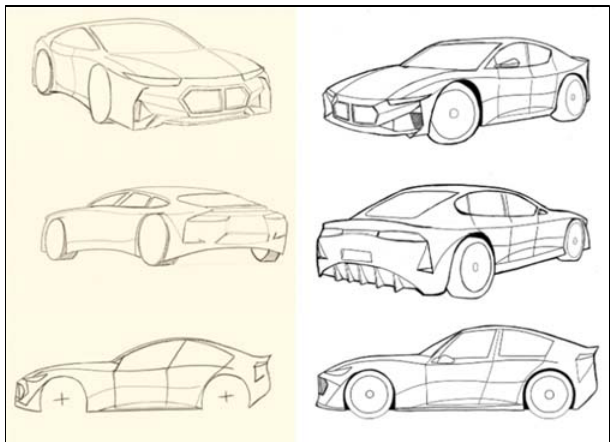
Figure 6. Sketches of the advanced proposal.